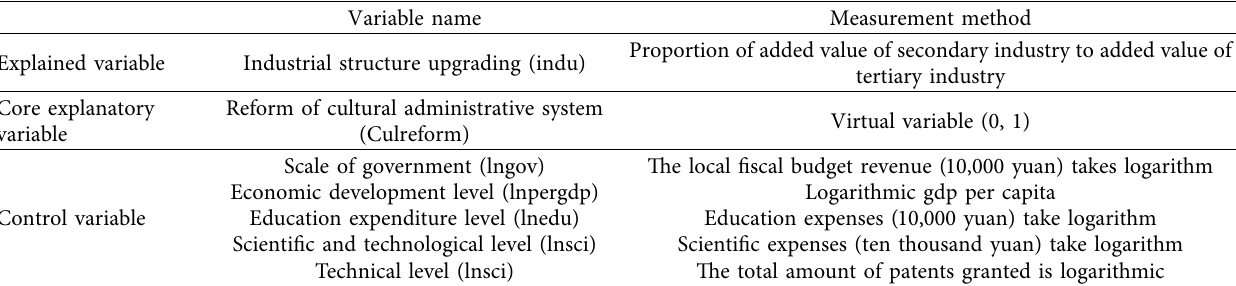
Table 1: Main variables and specific calculation